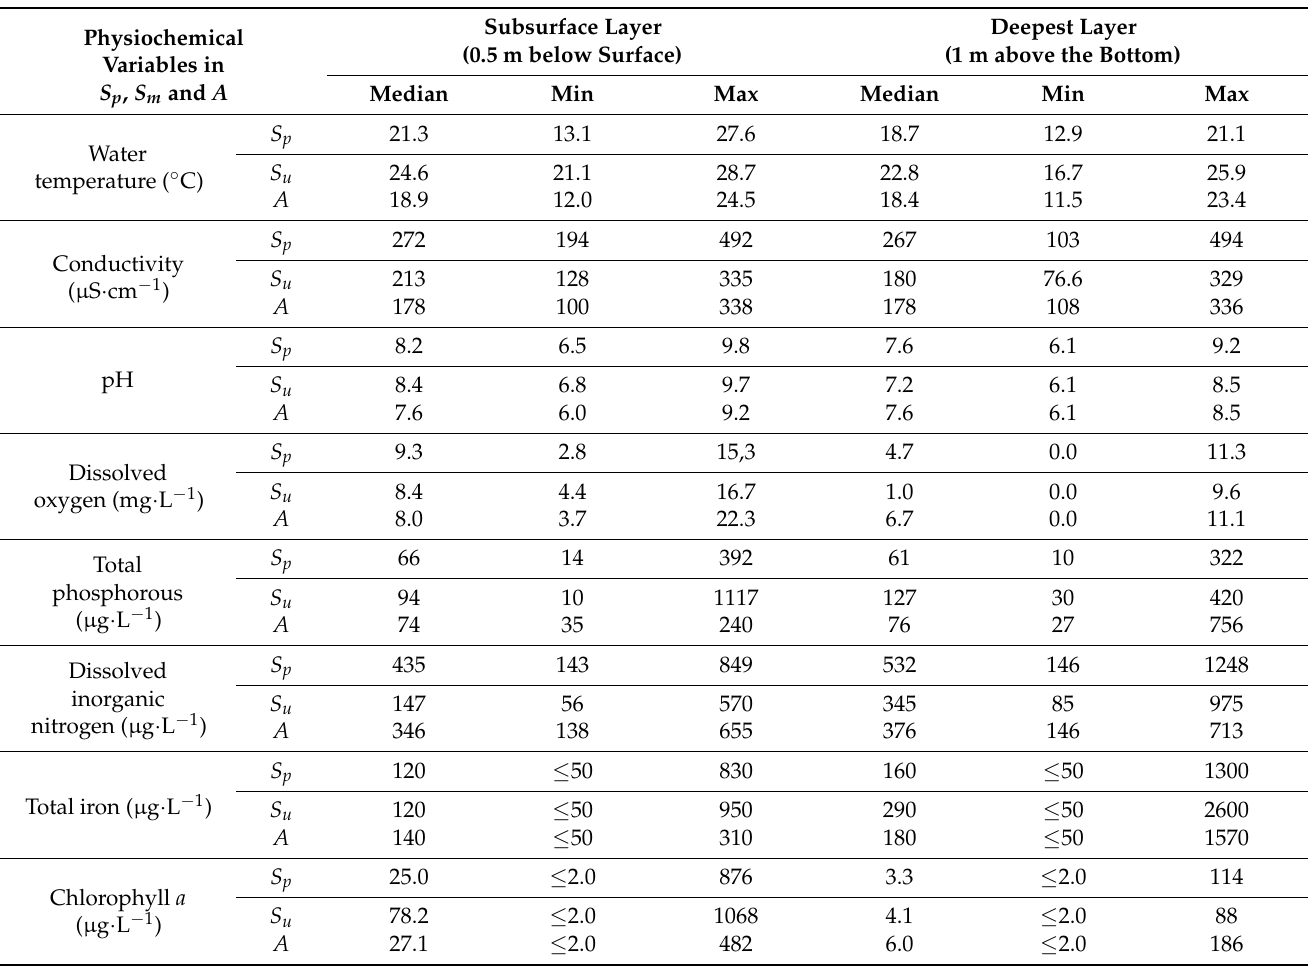
Table 1. Physicochemical characteristics of the San Roque reservoir in spring ( S p ), summer ( S u ) and autumn ( A ) at the center of the reservoir (for the subsurface and deepest layers of the water column). Monthly measurements obtained from the period 1999–2018 are presented as median, minimum and maximum values. Data were provided by the Continuous Program of Water Quality Monitoring